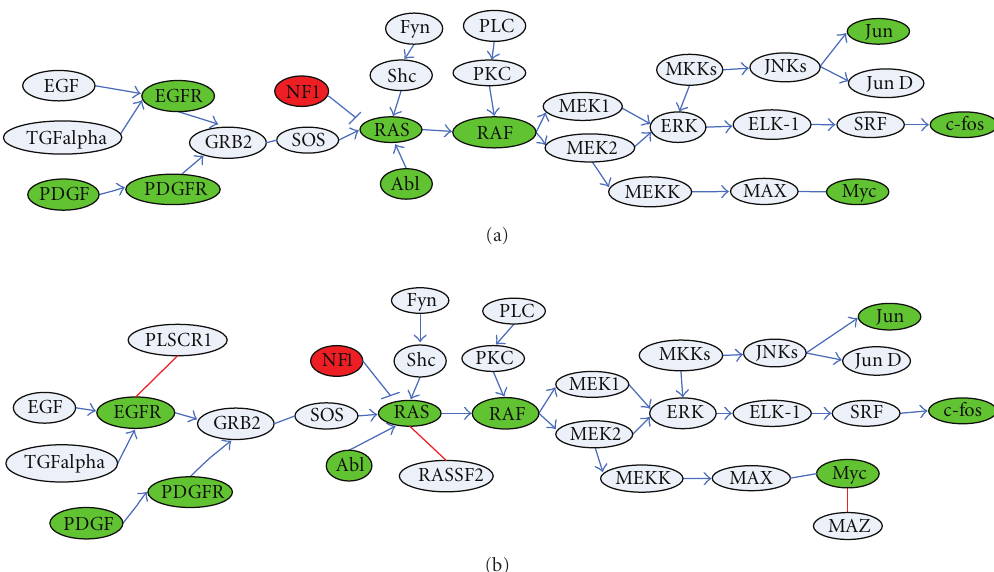
Figure 5: (a) Growth signal pathway. (b) Di ff erentially changed relations in growth signal pathway. Red edges represent di ff erentially changed relations. Blue edges represent unchanged relations. Red nodes represent tumor suppressor genes, and green nodes represent oncogenes.